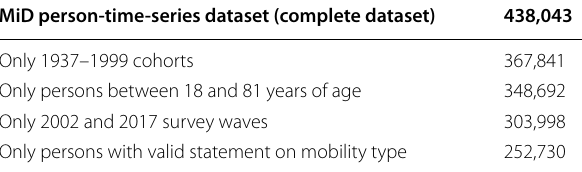
Source: Mobility in Germany: MiD person-time-series dataset (own calculations)